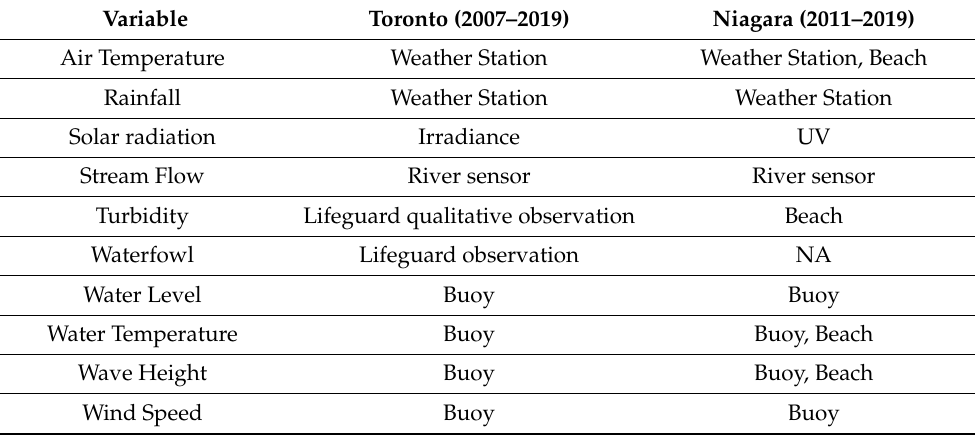
Table 2. Summary of predictors included in analysis from Toronto and Niagara